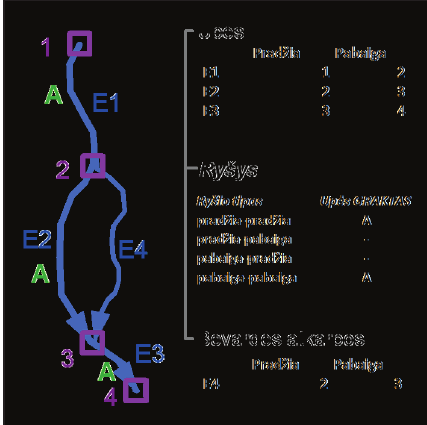
Fig. 2. Determining relationships between rivers and unnamed hydrographical lines using start and end nodes of the